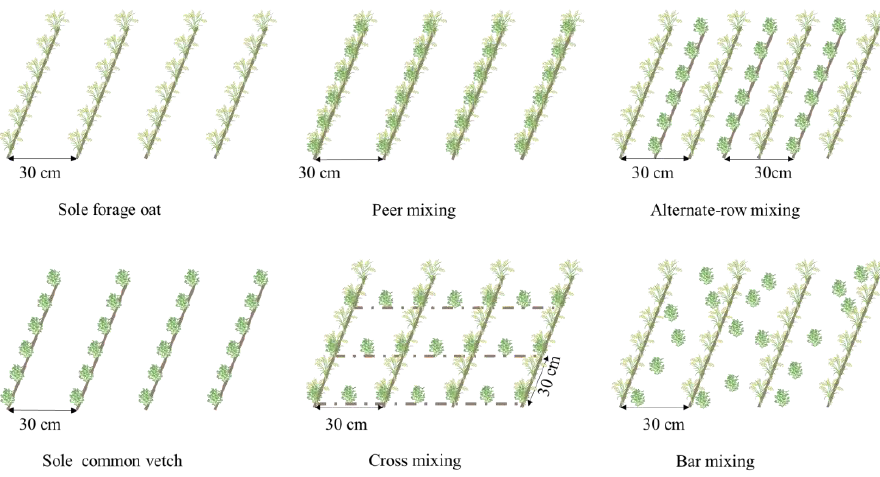
Figure 2. Schematics for different planting patterns during the experimental period. Table 1. The information about the forage oat and common vetch. Forage